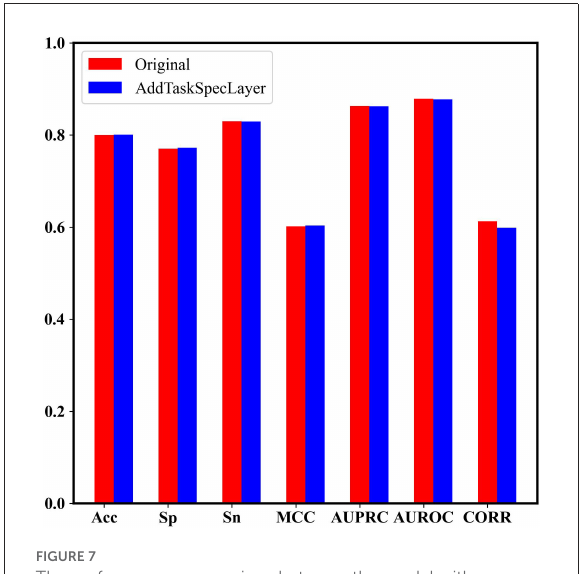
FIGURE7 The performance comparison between the model with task-specific dense network and our original